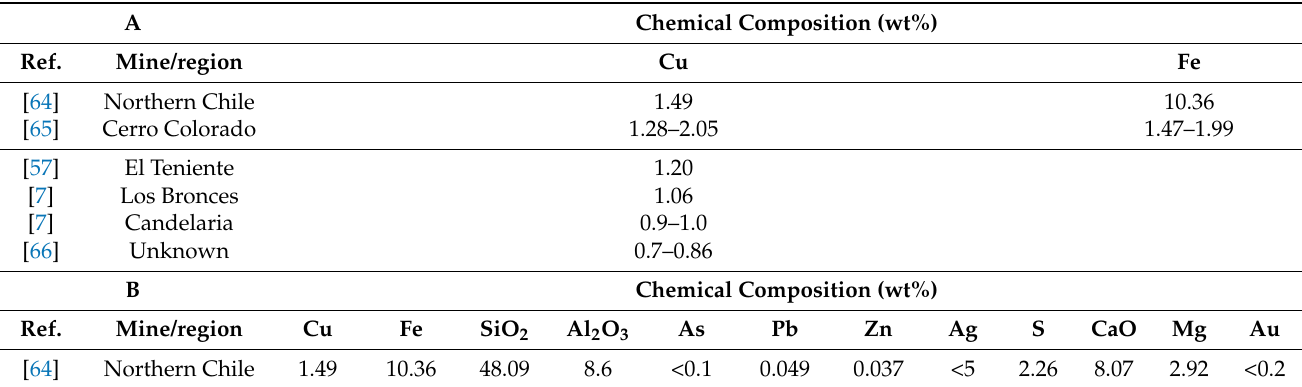
Table 3. Chemical composition of copper sulfide ores from Chile